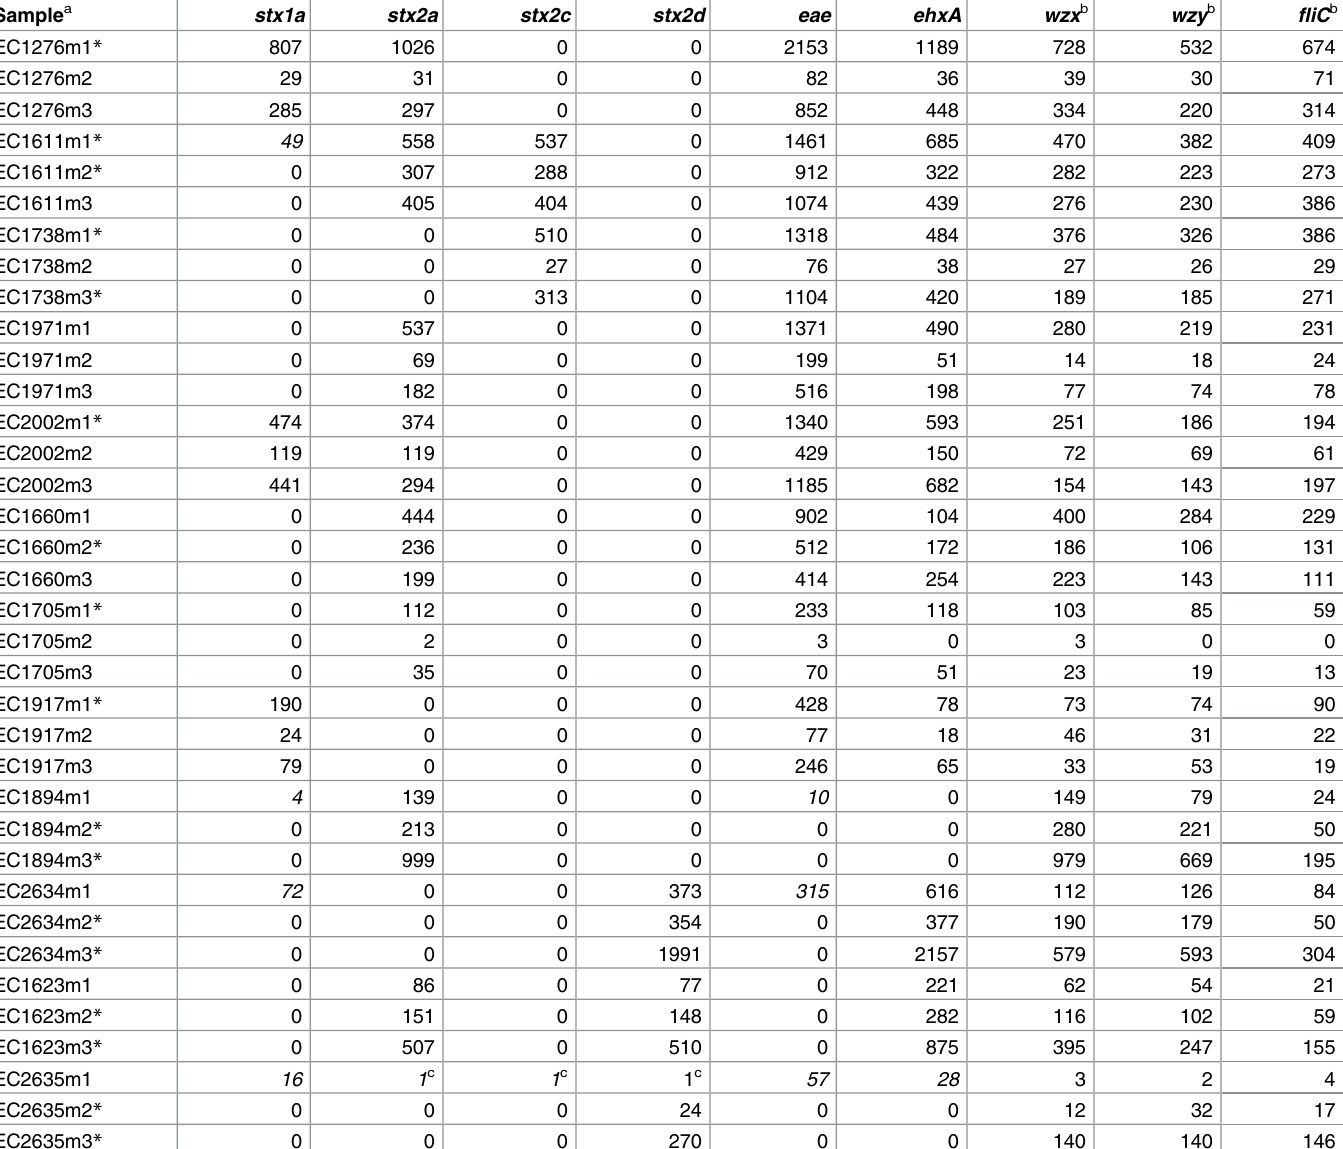
Table 2. Read counts mapping to virulence genes and serotyping